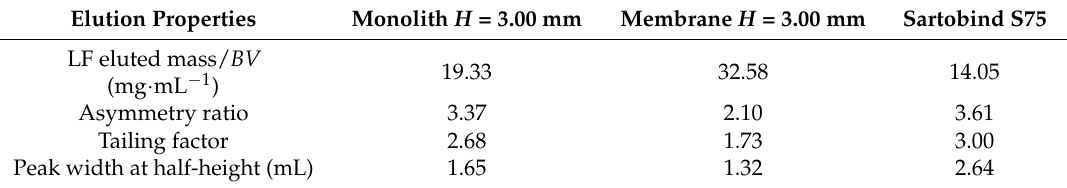
Figure 6. LF elution peaks using for elution 2 M NaCl in phosphate buffer for the membrane, monolith with H = 3 mm in the CIM housing and the Sartobind S75 device at a flow rate of 12.0 BV · min − 1 . Table 3. LF characteristics of elution peaks using the membrane and monolith. LF loading using 2 M NaCl in phosphate buffer solution at 12.0 BV · min − 1 .